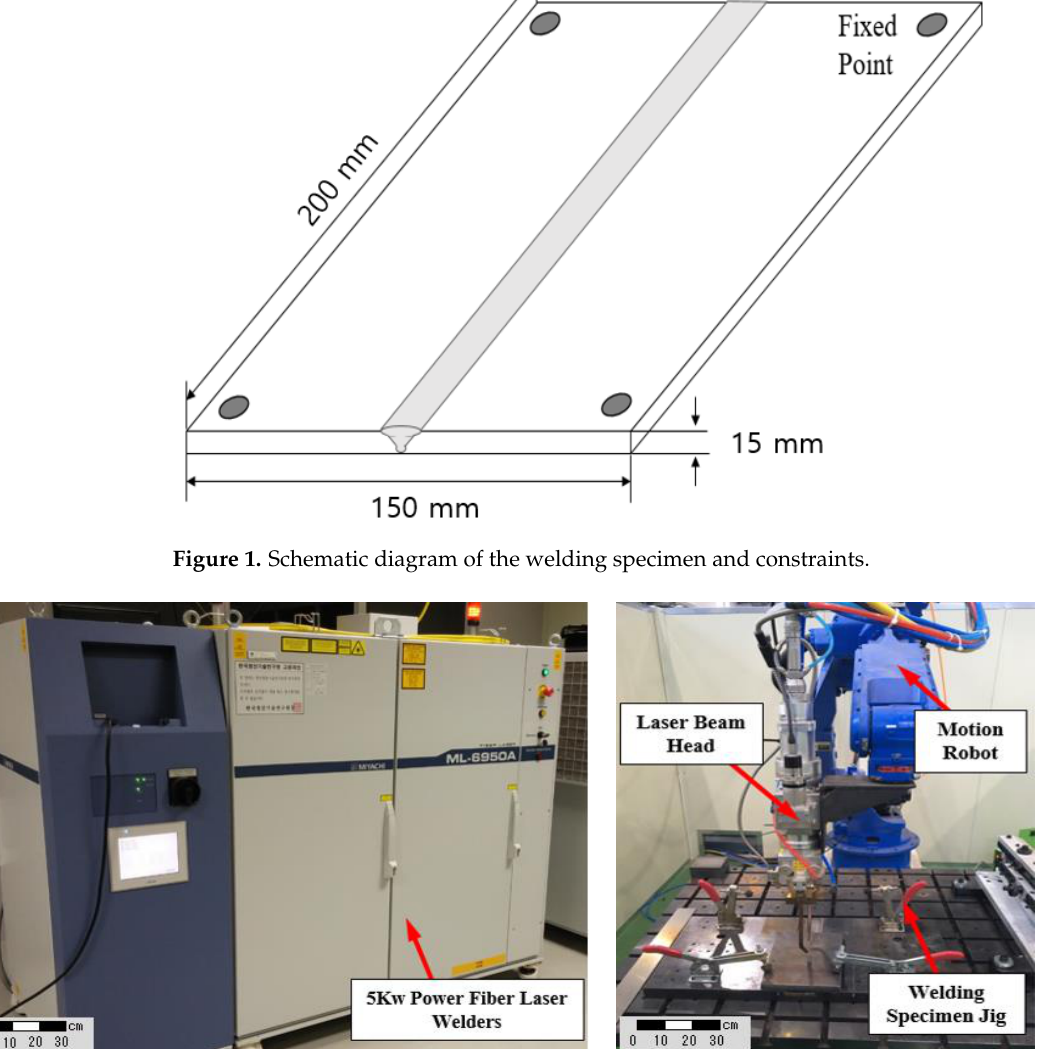
Figure 2. Fiber laser welding equipment. ( a ) 5kw fiber laser power source; ( b ) welding torch head.